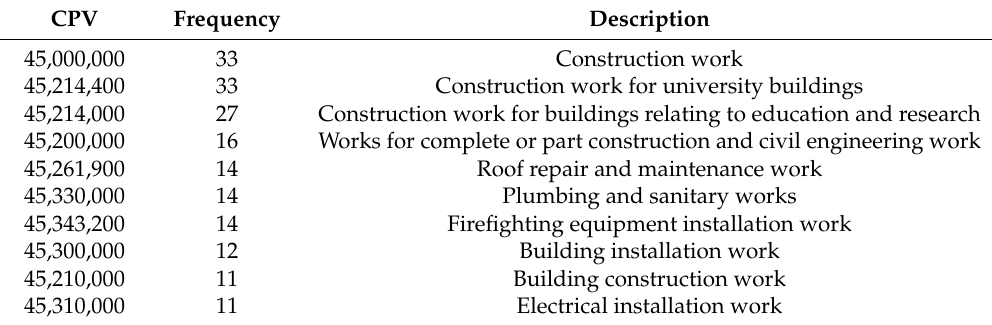
Table 2. CPV’s of the sample of